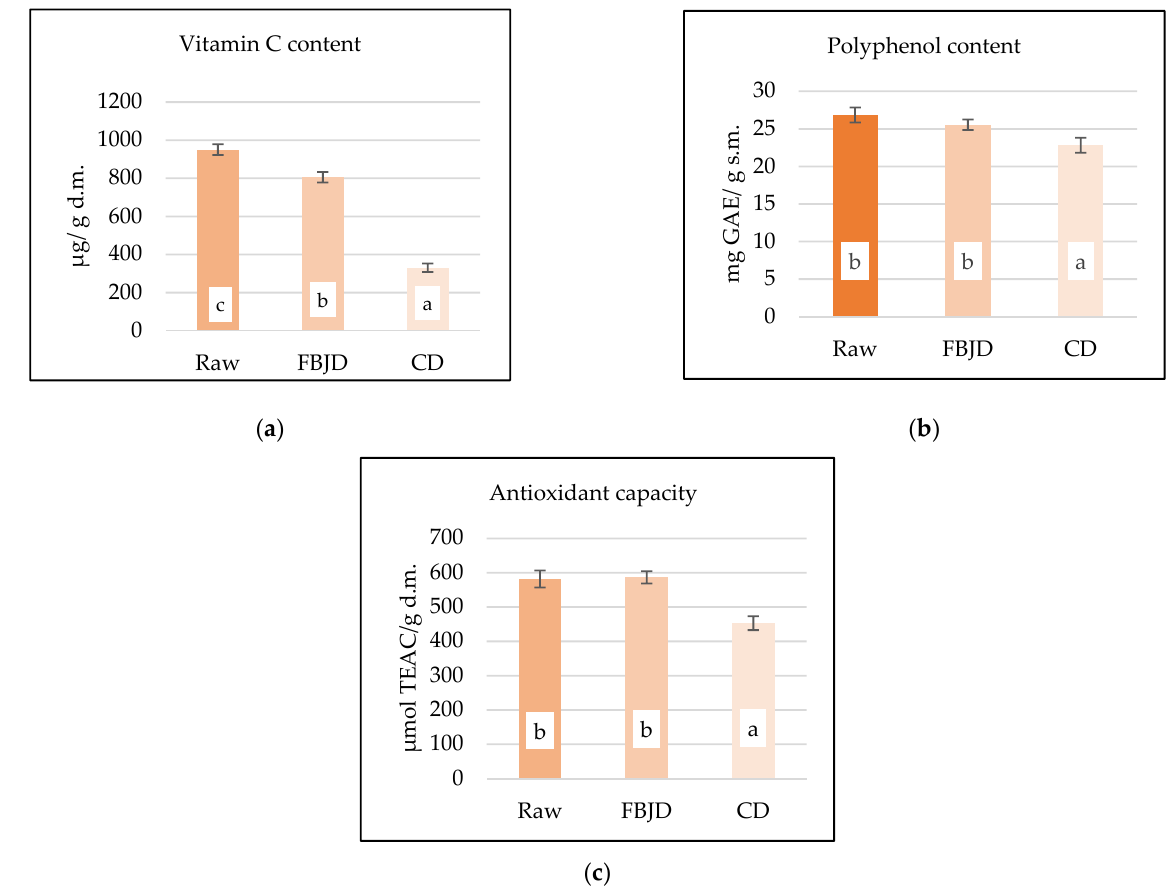
Figure 4. Vitamin C ( a ) and polyphenol ( b ) contents and antioxidant properties ( c ) of chokeberry and chokeberry powders obtained by the CD method in 70 °C to a w of approx. 0.2 and FBJD method using pre-drying at 70 °C. Values are means ± standard deviation ( n = 3); a,b—different letters in the same line are significantly different (Duncan’s test, p < 0.05),FBJD—fluidized-bed jet milling and drying; CD—convective drying; GAE—gallic acid equivalent; TEAC—Trolox equivalent antioxidant capacity; d.m.—dry mass.